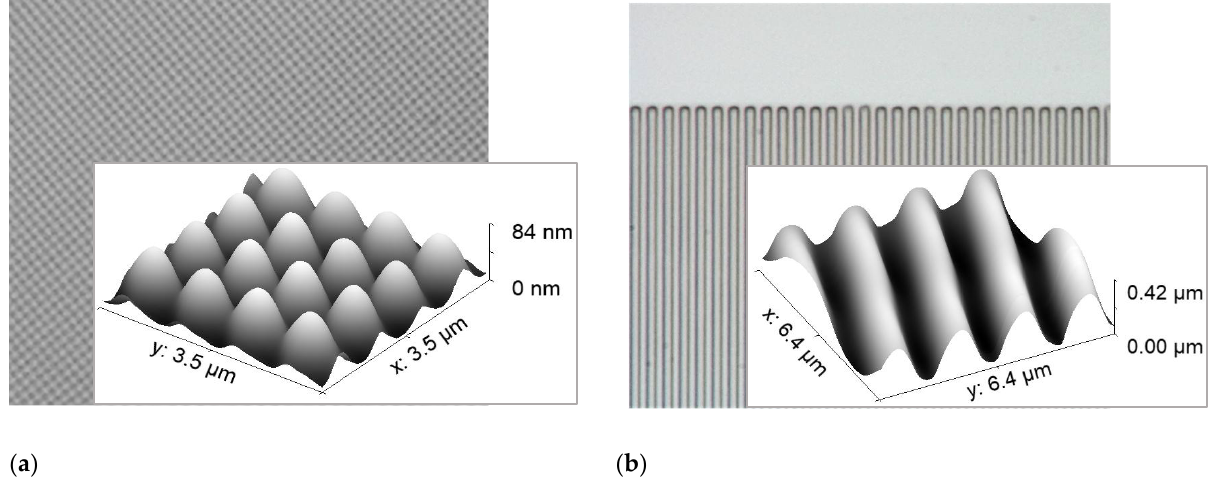
Figure 8. Images of UV imprint of [(N 11 VB) 2 Pr][Cl] + PG. Optical microscopy and AFM image of ( a ) checkerboard pattern, and ( b ) relief diffraction grating 1.7 µ m. AFM data was acquired with the use of a Park Systems XE-70 (Suwon, Korea).